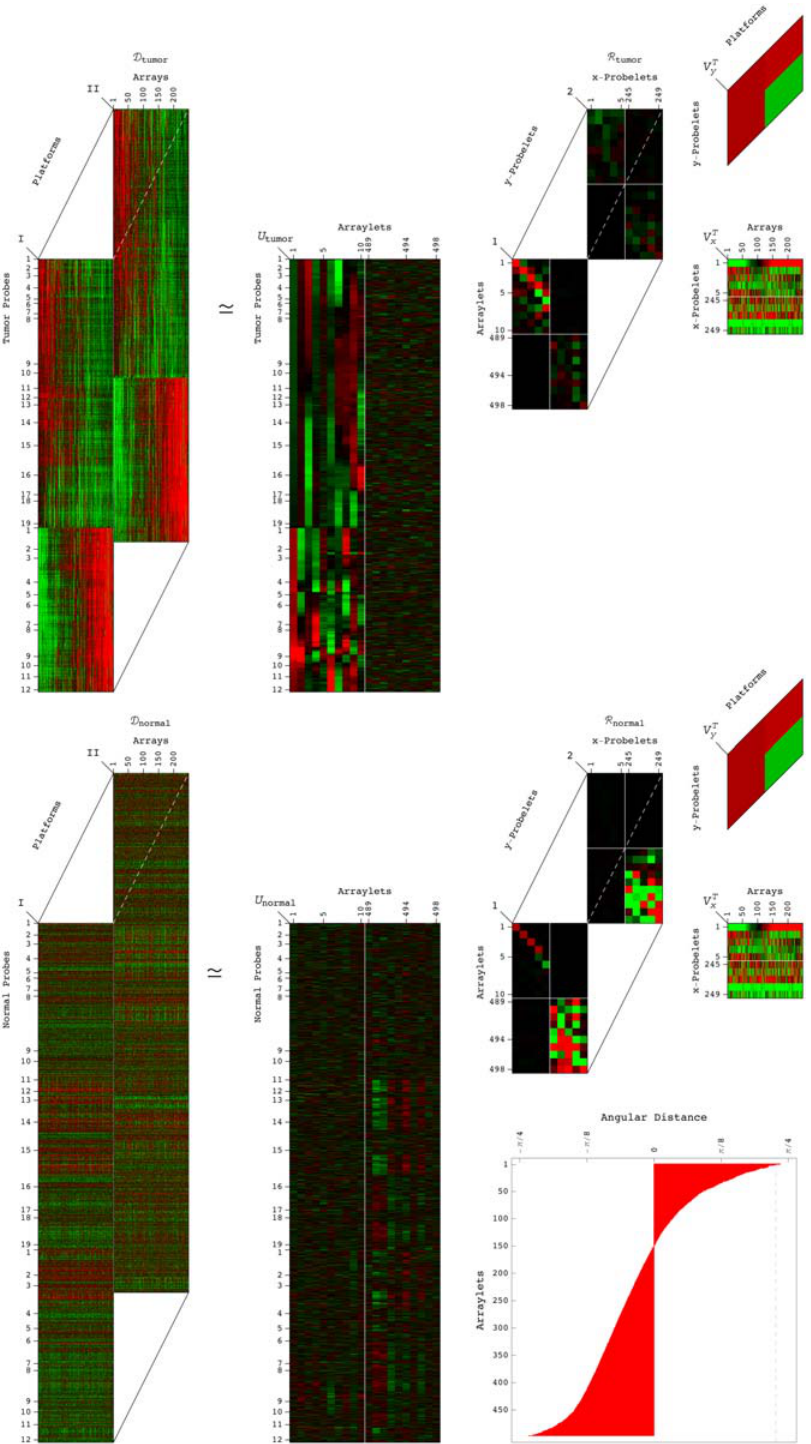
Fig 1. Tensor generalized singular value decomposition (GSVD) of the patient- and platform-matched DNA copy-number profiles of the 6p+12p chromosome arms. For each chromosome arm or combination of two chromosome arms, the structure of the tumor and normal discovery datasets ( D 1 and D 2 ) is that of two third-order tensors with one-to-one mappings between the column dimensions but different row dimensions. The patients, platforms, probes, and tissue types, each represent a degree of freedom. Unfolded into a